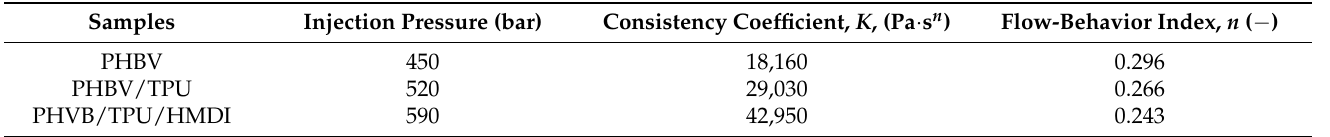
Figure 7. The viscosity as a function of thee apparent shear rate of the neat PHBV and the PHBV/TPU blends. Table 4. The processing injection pressure and capillary rheometry parameters.